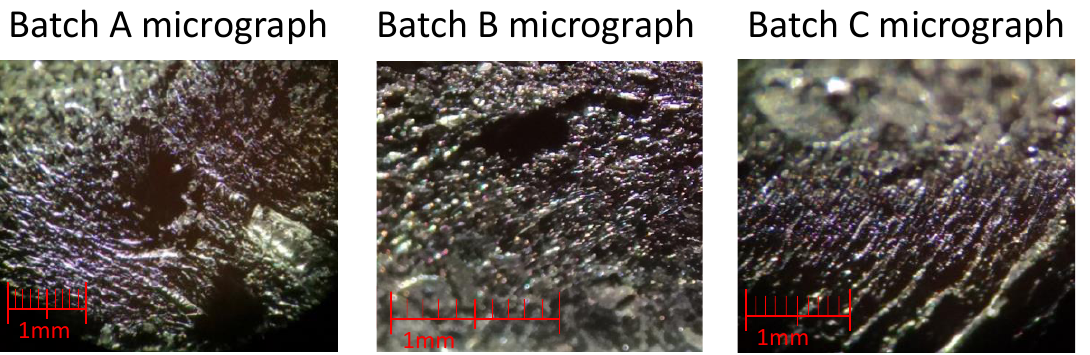
Figure 9. Micrographs of the cross-section of Batch A (on the left ), Batch B ( center ), and Batch C (on the right ).